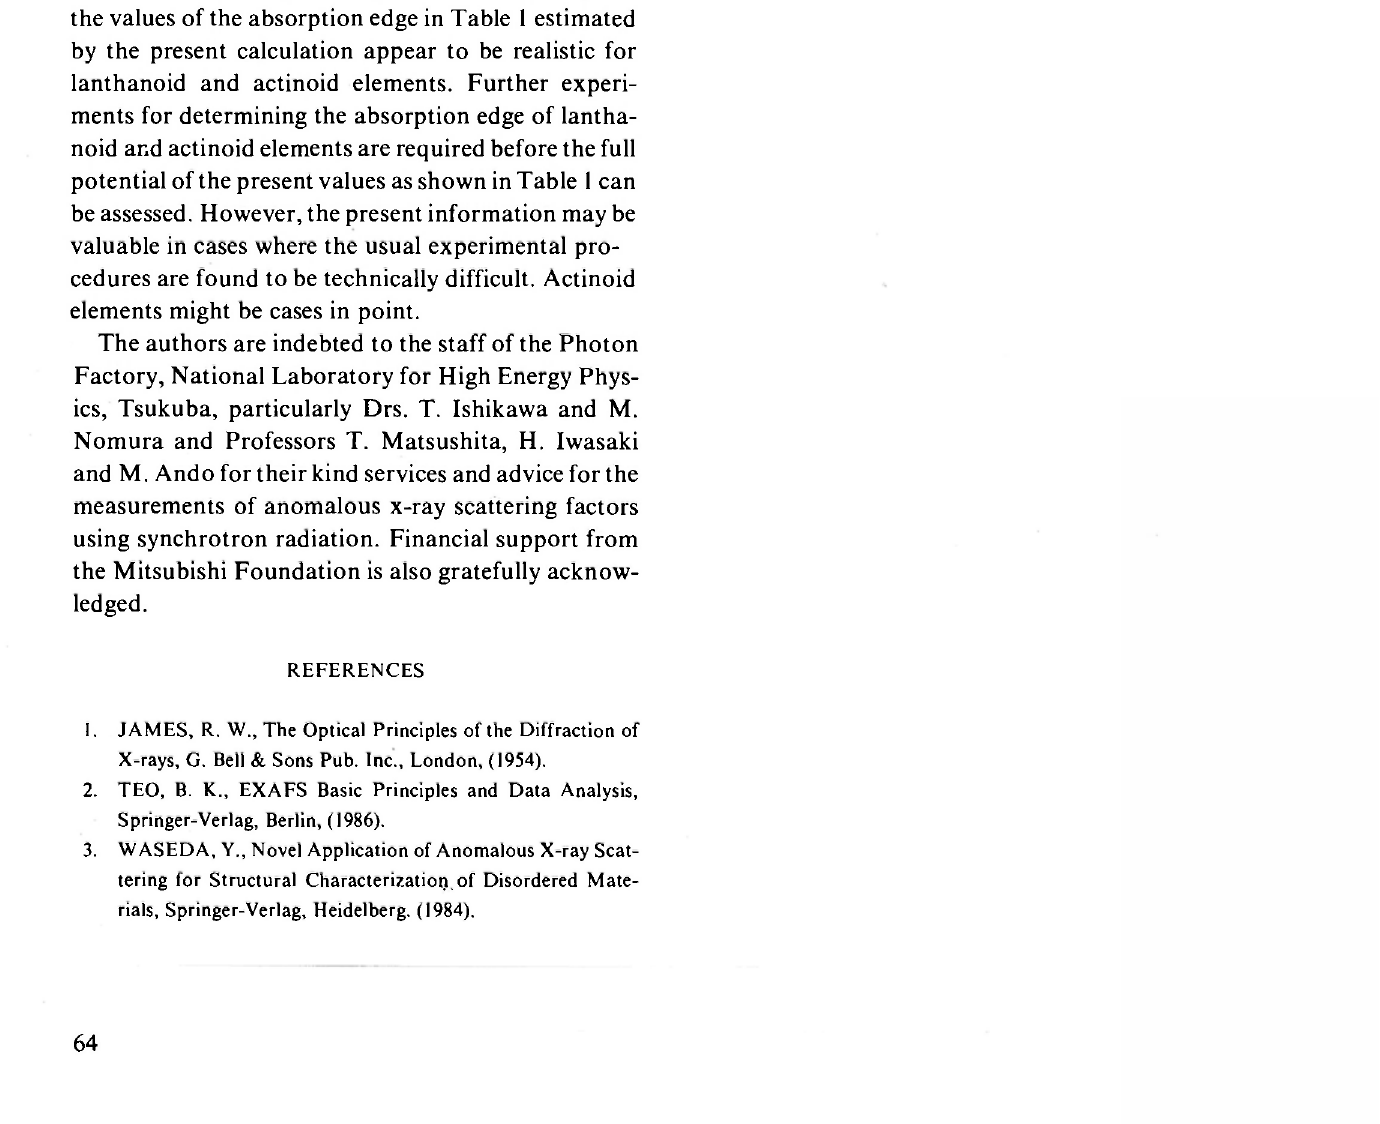
Fig. 3: Energy dependence of anomalous dispersion terms for Ge near the K-edge and for Bi near the Lm edge. Solid line: calculation; solid circle: